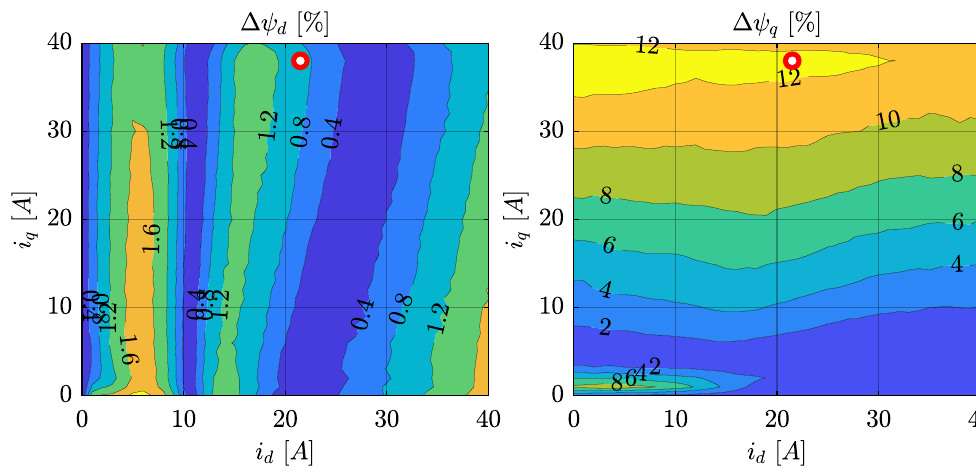
Figure 15. Flux linkage estimation difference d -axis ( left ) and q -axis ( right ) for the TCICSM. From the comparison with Figure 10, it can be concluded that the normalized flux difference maps have a very good agreement. In case of the TCICSM, the maximum normalized flux differences are 2.18 % and 13.3% for the d - and q -axes, respectively. The measured torque map during identification and difference contours are presented in Figure 16.